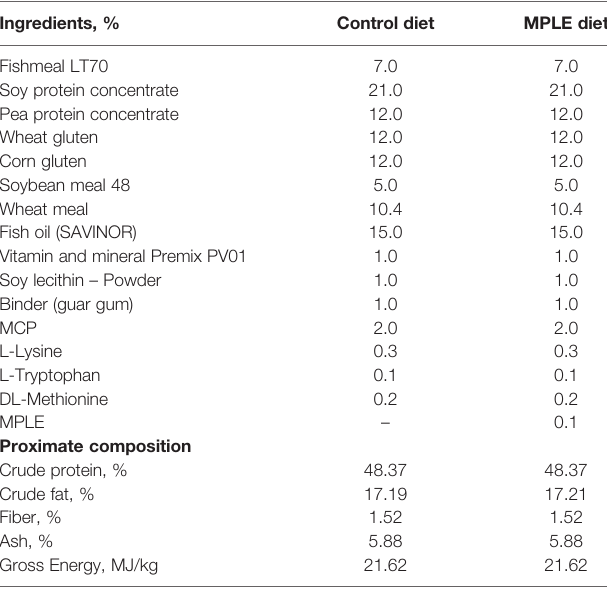
TABLE 1 | List of ingredients and proximal composition of experimental diets; control and a basal diet supplemented with a medicinal plant leaf extract (MPLE) obtained from sage ( Salvia of fi cinalis ) and lemon verbena ( Lippia citriodora ). Ingredients, % Control diet MPLE diet Fishmeal